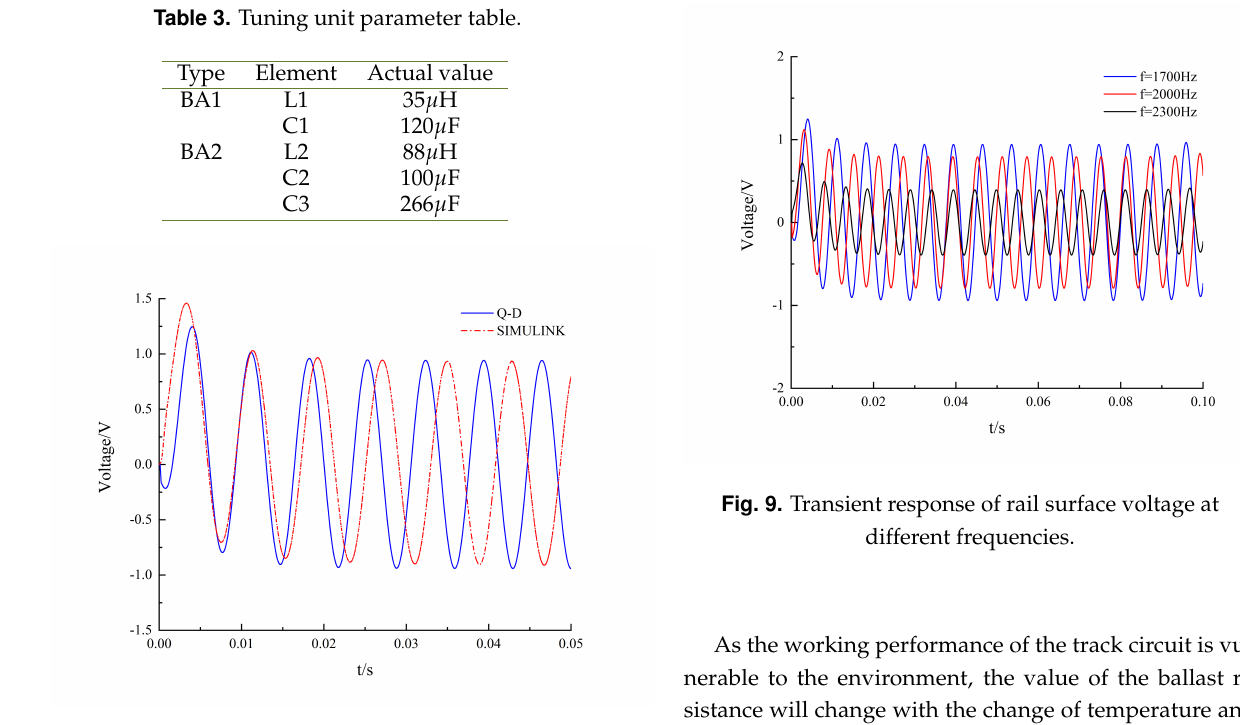
Fig. 8. Simulink result and Q-D algorithm calculation result.